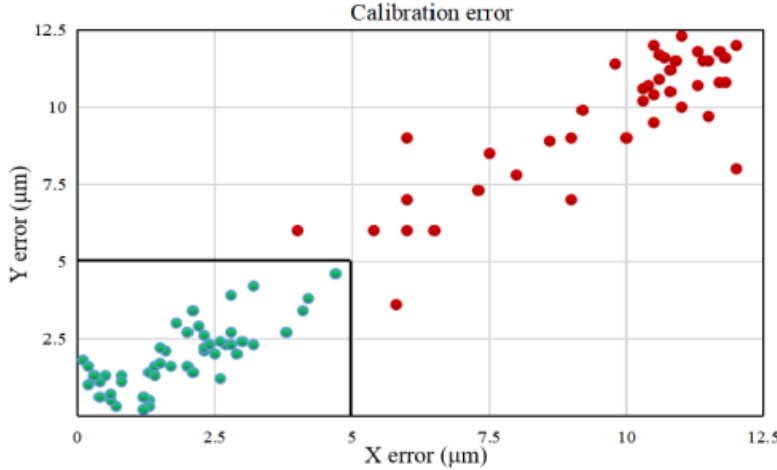
Figure 9. The calibration error of two calibration methods. The green dots are calibration errors of oocytes in the automated group, and the red dots are calibration errors of oocytes in the manual group.